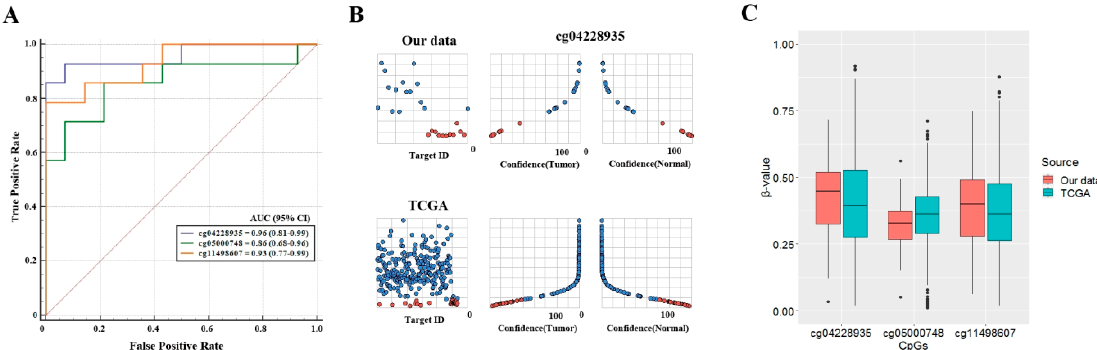
Figure 2. Evaluation of prediction performance of five supervised machine learning algorithms in non-small cell lung cancer (NSCLC). ( A ) The true and false positive rates of logistic regression model based on three CpGs were evaluated in a test dataset (N = 28) of 42 NSCLCs, and the receiver operating characteristic (ROC) curves were plotted using the MedCalc software. ( B ) The prediction certainty of the support vector machine model was evaluated in the test dataset of our data and TCGA lung cancer. The X-axis indicates the degree (0% to 100%) of certainty for prediction of our and TCGA tissues as normal or tumor for each β -value on the Y-axis. The sky blue and red orange circles indicate tumor and normal tissues, respectively. ( C ) The β -values of the three CpGs in our and TCGA data were compared to understand the difference of RUNX1 hypermethylation among other ethnic groups or populations.